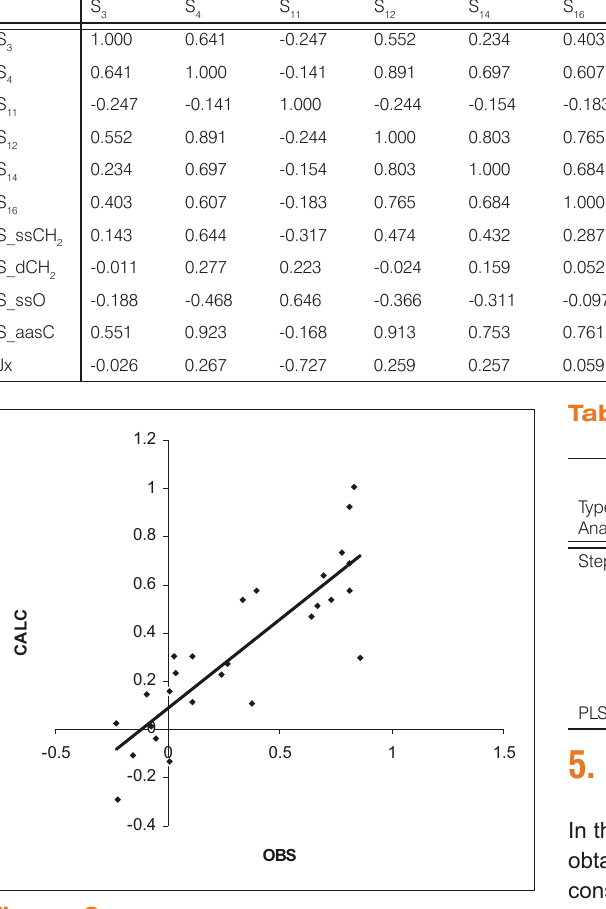
) and calculated LPO